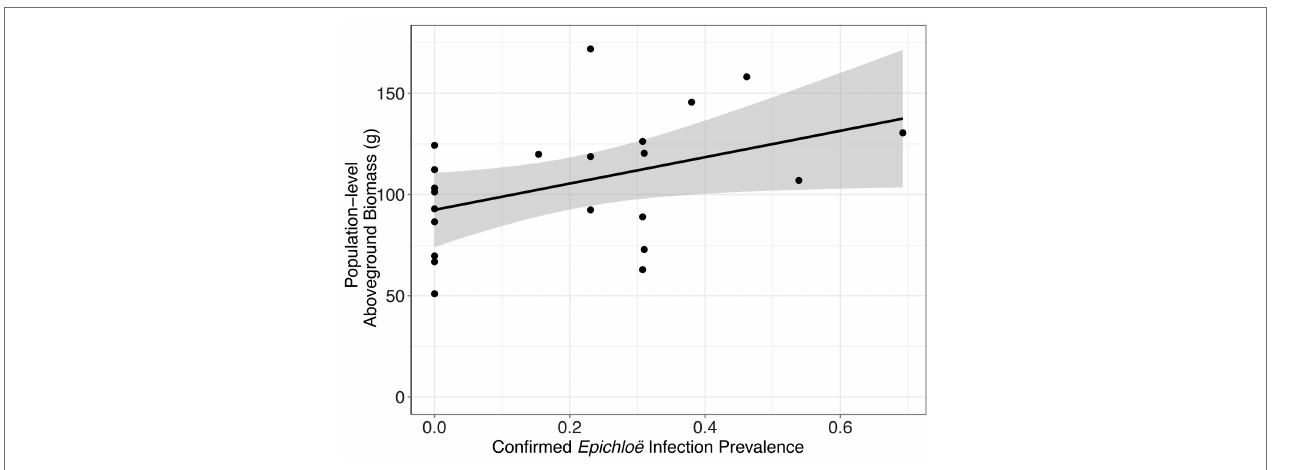
FIGURE 3 | Epichloë infection prevalence was associated with greater host aboveground biomass at the population level. Each point represents a host population, and the bold line represents the best fit linear model. At the population level, confirmed Epichloë prevalence was clearly positively associated with population-level host aboveground biomass at the end of the experiment ( p = 0.047).